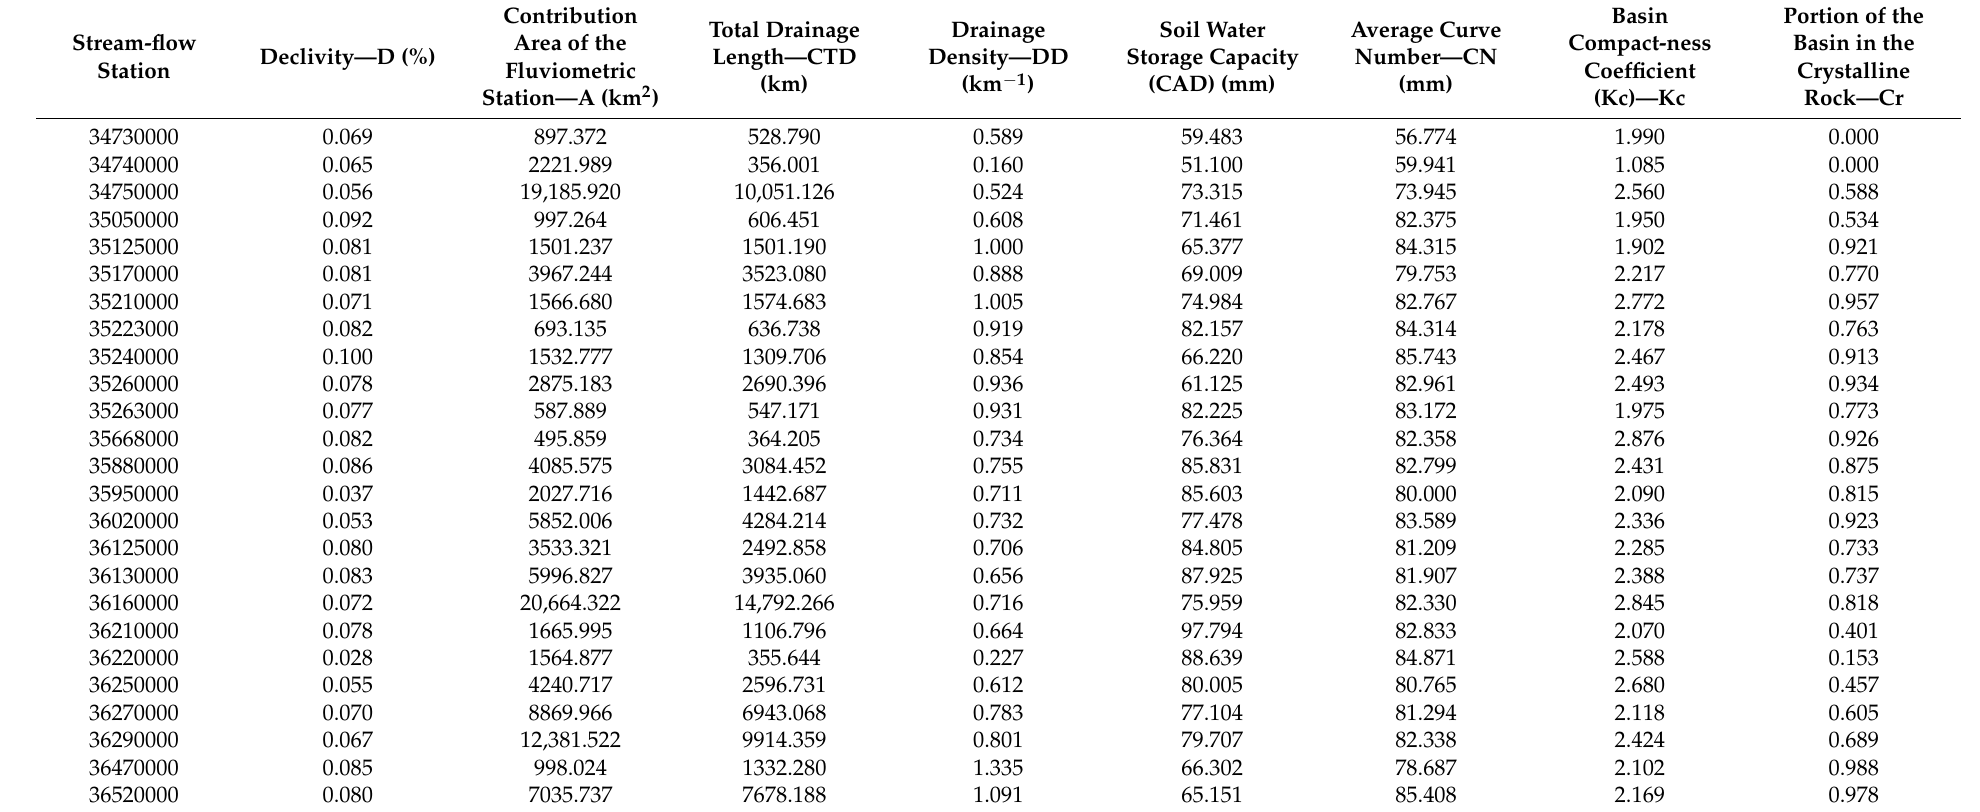
Table 1. Basins’ physical